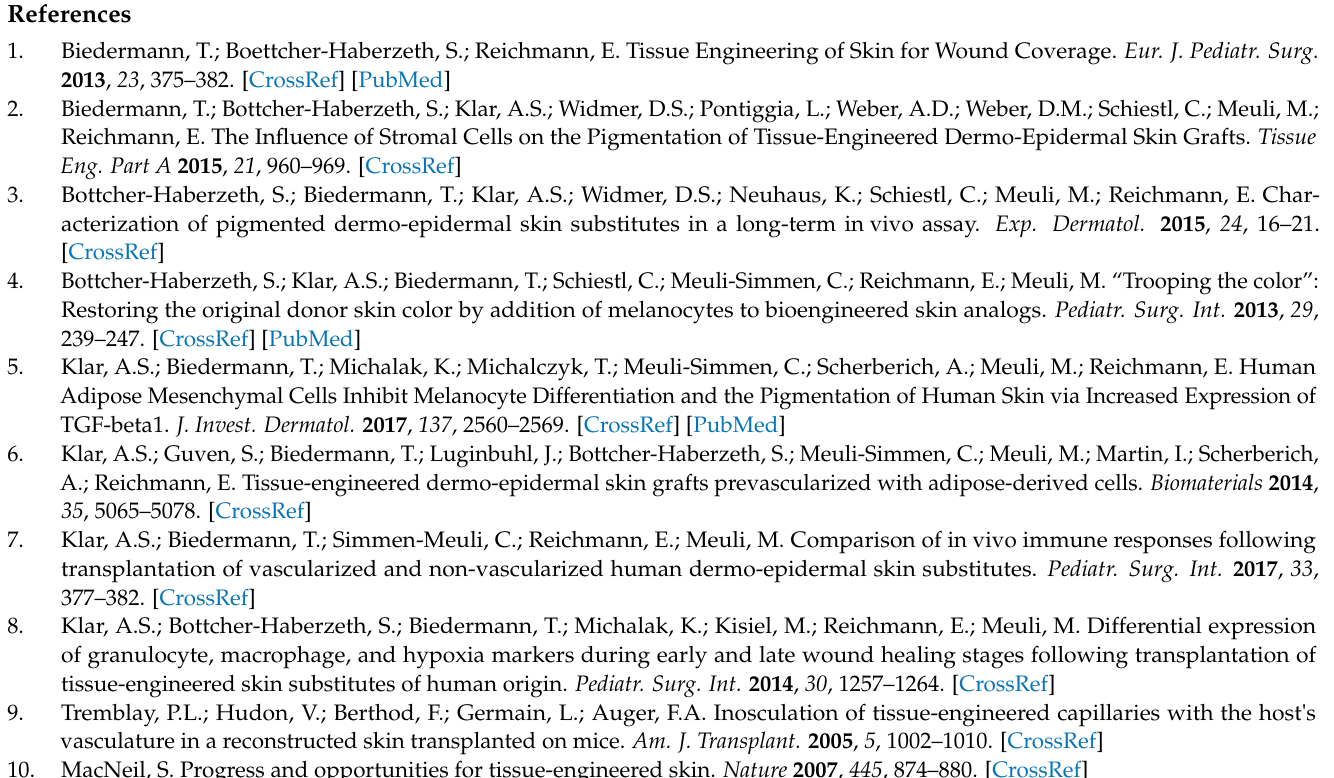
Figure S7: Expression of CD200 in normal a/j human skin. Figure S8: Expression of CD200 in normal a/j human skin; Figure S9: Expression of CD200R in rat lymph